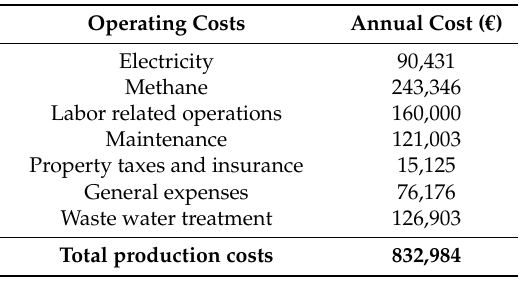
Table 6. Total annual production costs of HTC